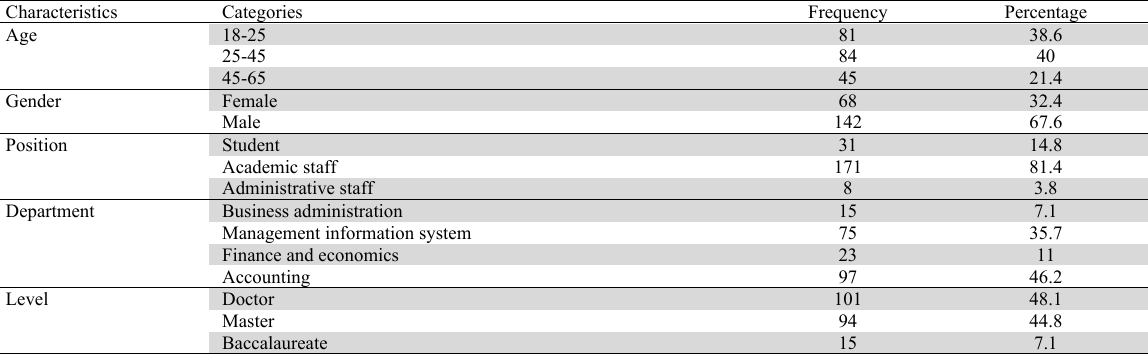
Respondents’ profile information